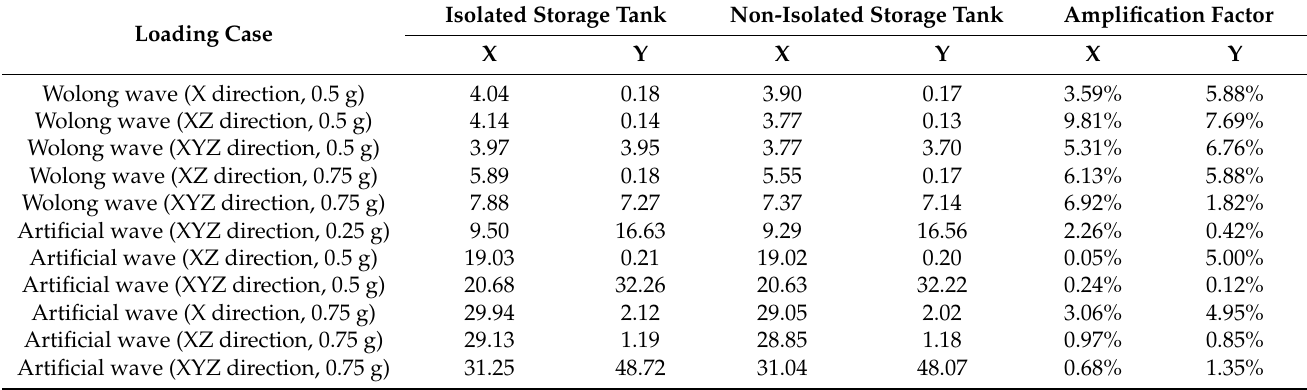
Table 4. Comparison of the maximum displacement response of the tank dome under different working conditions (mm).